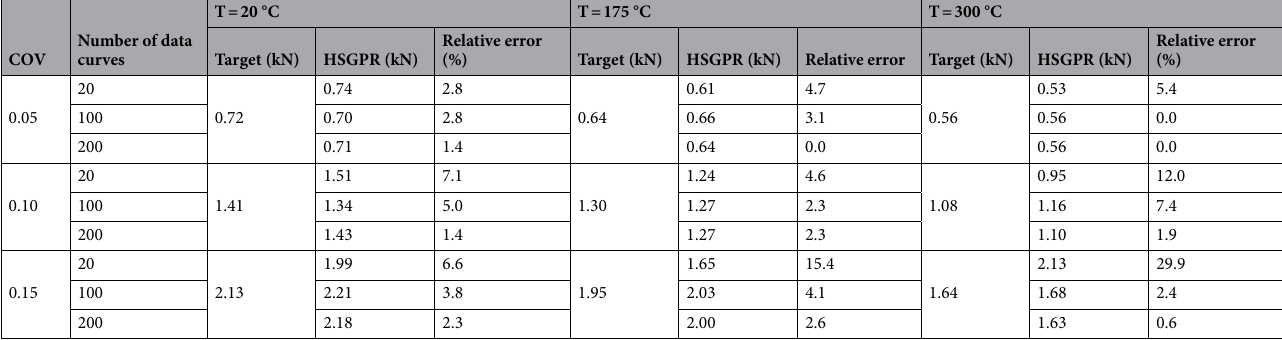
Number of data curves